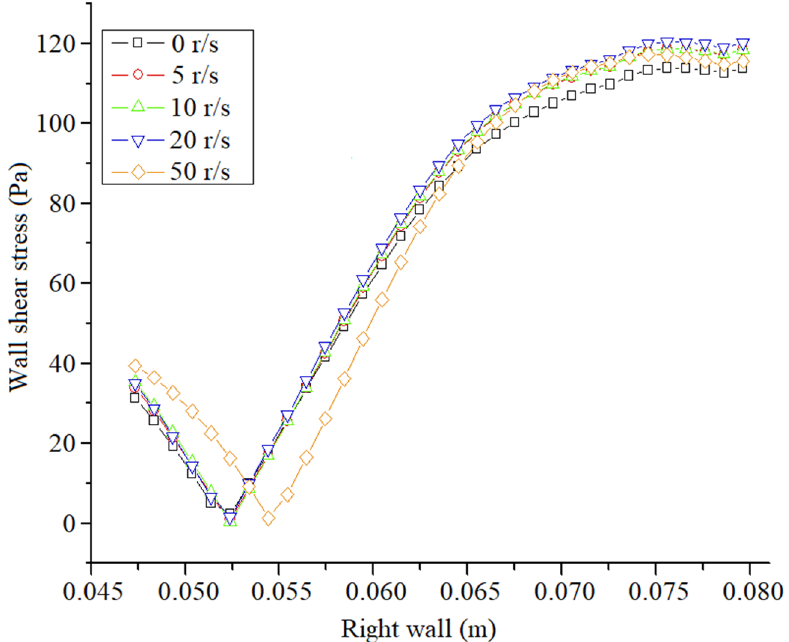
Figure 15. Distribution of shear stress on the right wall of supersonic fluidic element at different rotational angular velocities.